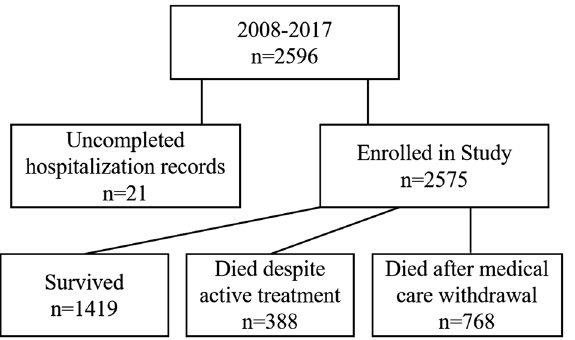
Figure 1. Extremely low birth weight infants discharged from 2008 to 2017 enrolled in the study.